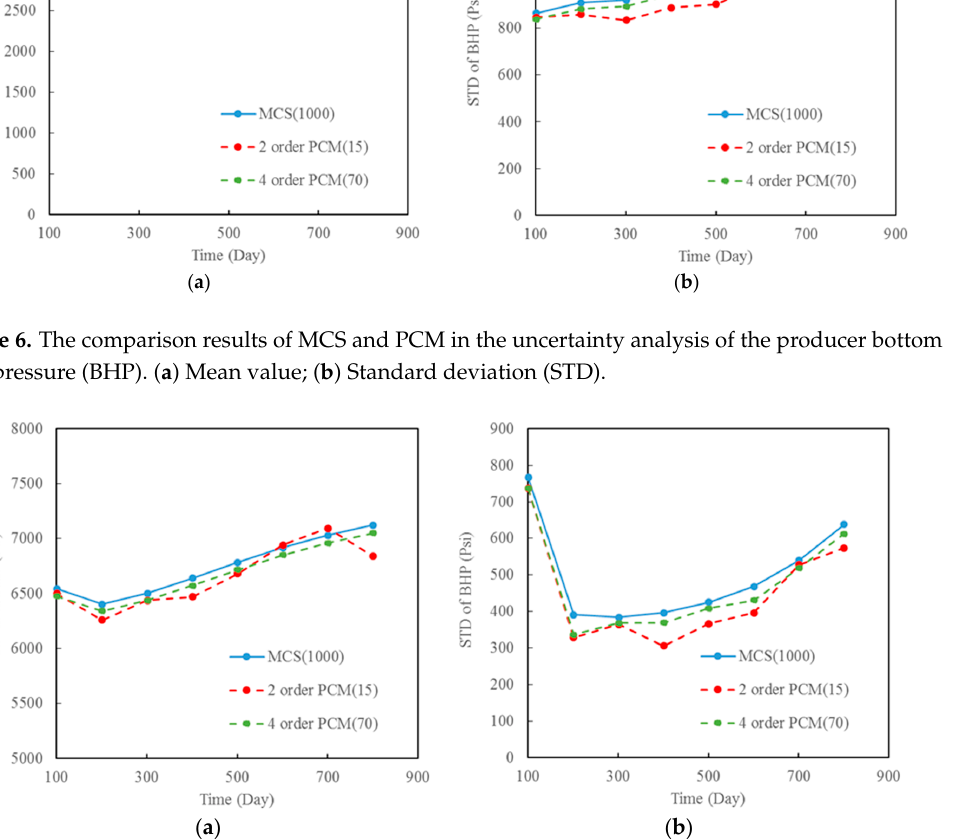
Figure 7. The comparison results of MCS and PCM in the uncertainty analysis of injector BHP. ( a ) Mean value; ( b ) Standard deviation (STD).